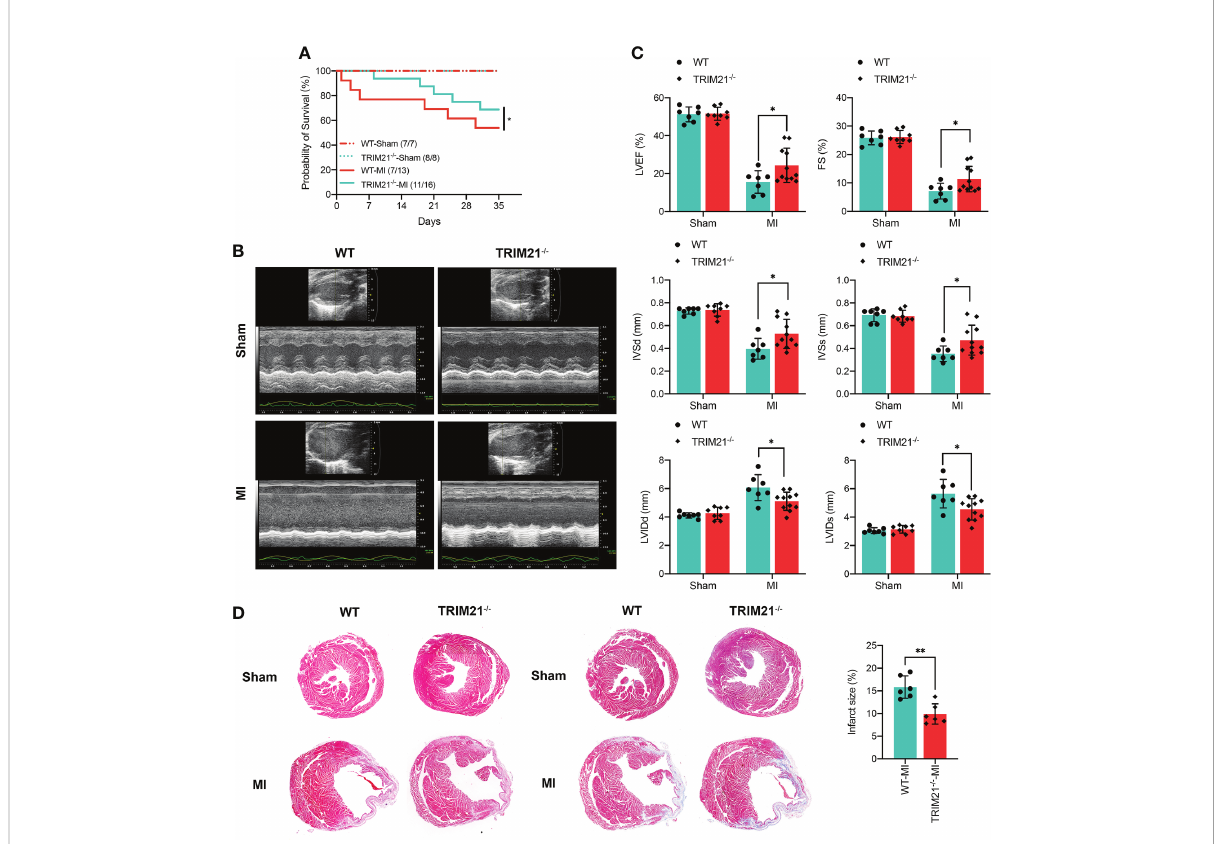
FIGURE 2 TRIM21 de fi ciency alleviates MI-induced changes in the cardiac structure and preserves cardiac function. (A) Survival rates after MI in WT and TRIM21 knockout (TRIM21 -/- ) mice. (B) Representative echocardiographic images of WT mice and TRIM21 -/- mice 3 days after sham operation or LAD ligation. (C) Quanti fi cation of the left ventricular ejection fraction, left ventricular fractional shortening, left ventricular end-systolic internal diameter, and end-diastolic internal diameter. For (B, C) , n = 7 – 11 mice/group pooled from 2 independent experiments. (D) Representative H&E staining and Masson Trichrome staining of the cardiac tissue sections of WT mice and TRIM21 -/- mice 3 days after sham operation or LAD ligation. Scale bar: 1 mm. Data are representative of 3 independent experiments. n = 2 mice/group. *P<0.05,